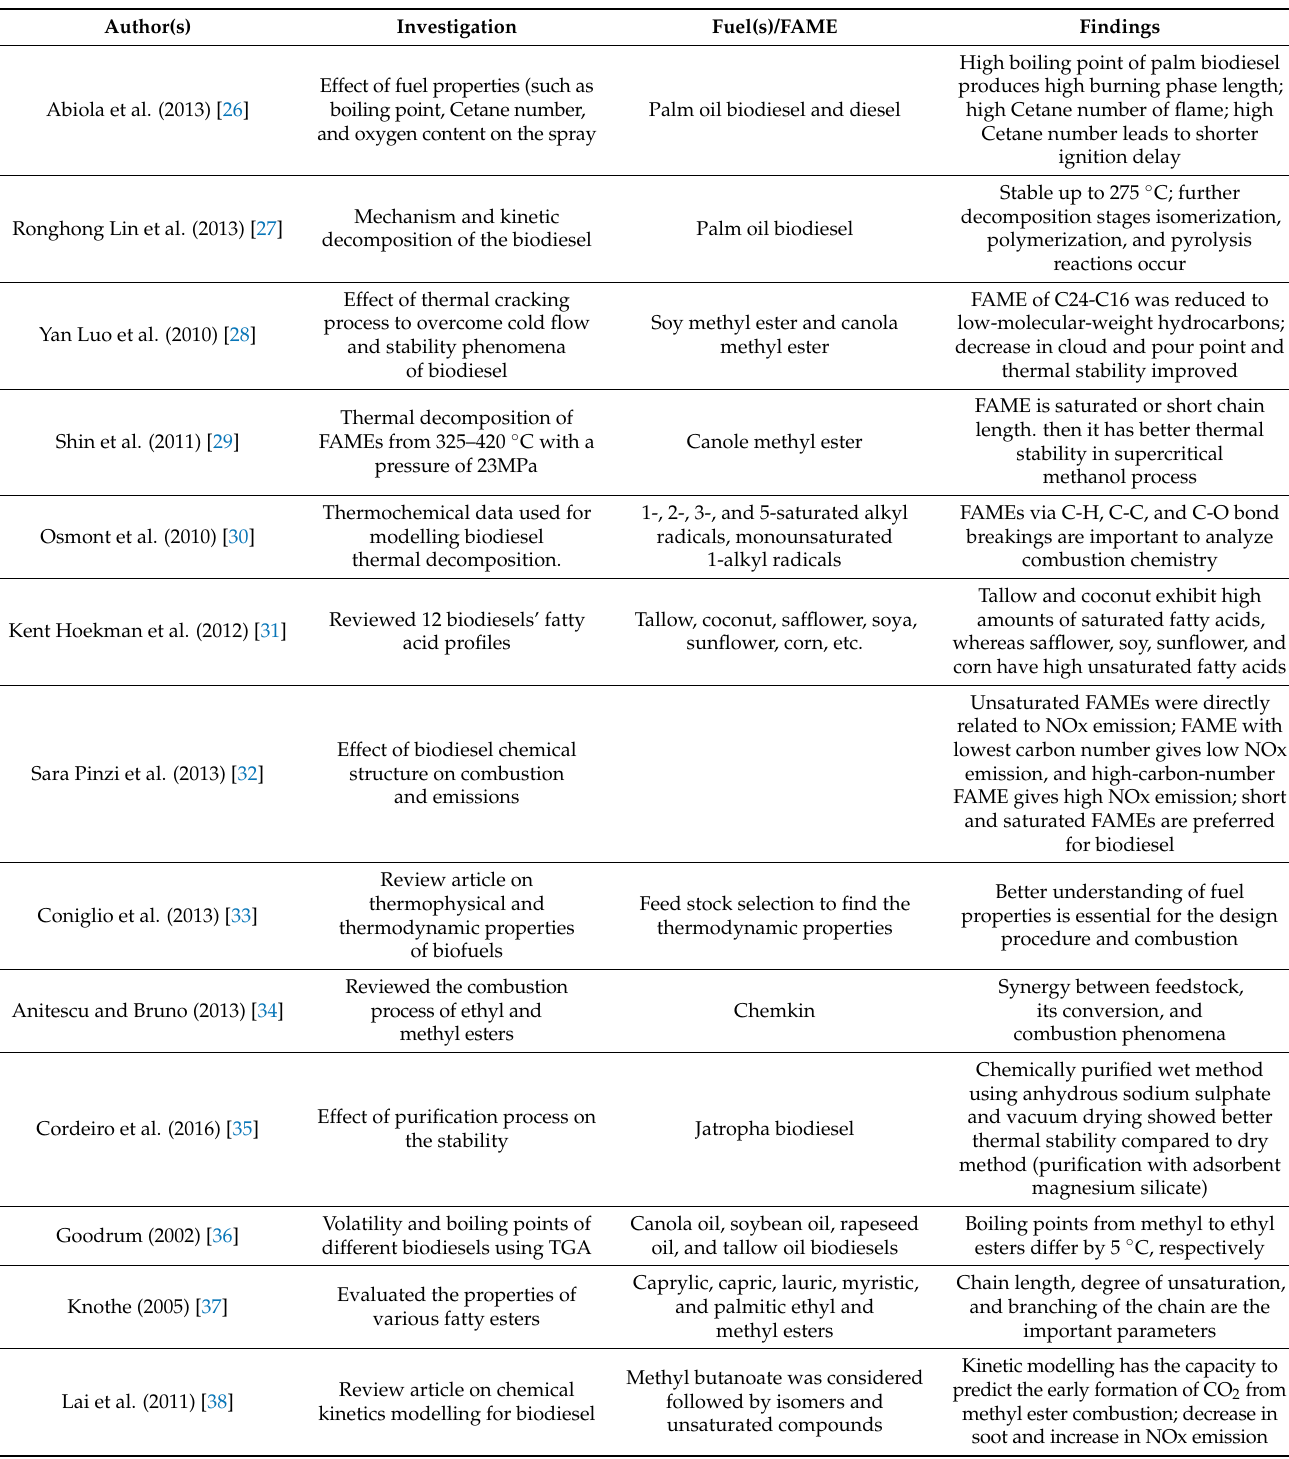
Table 1. A summary of articles related to the kinetics of